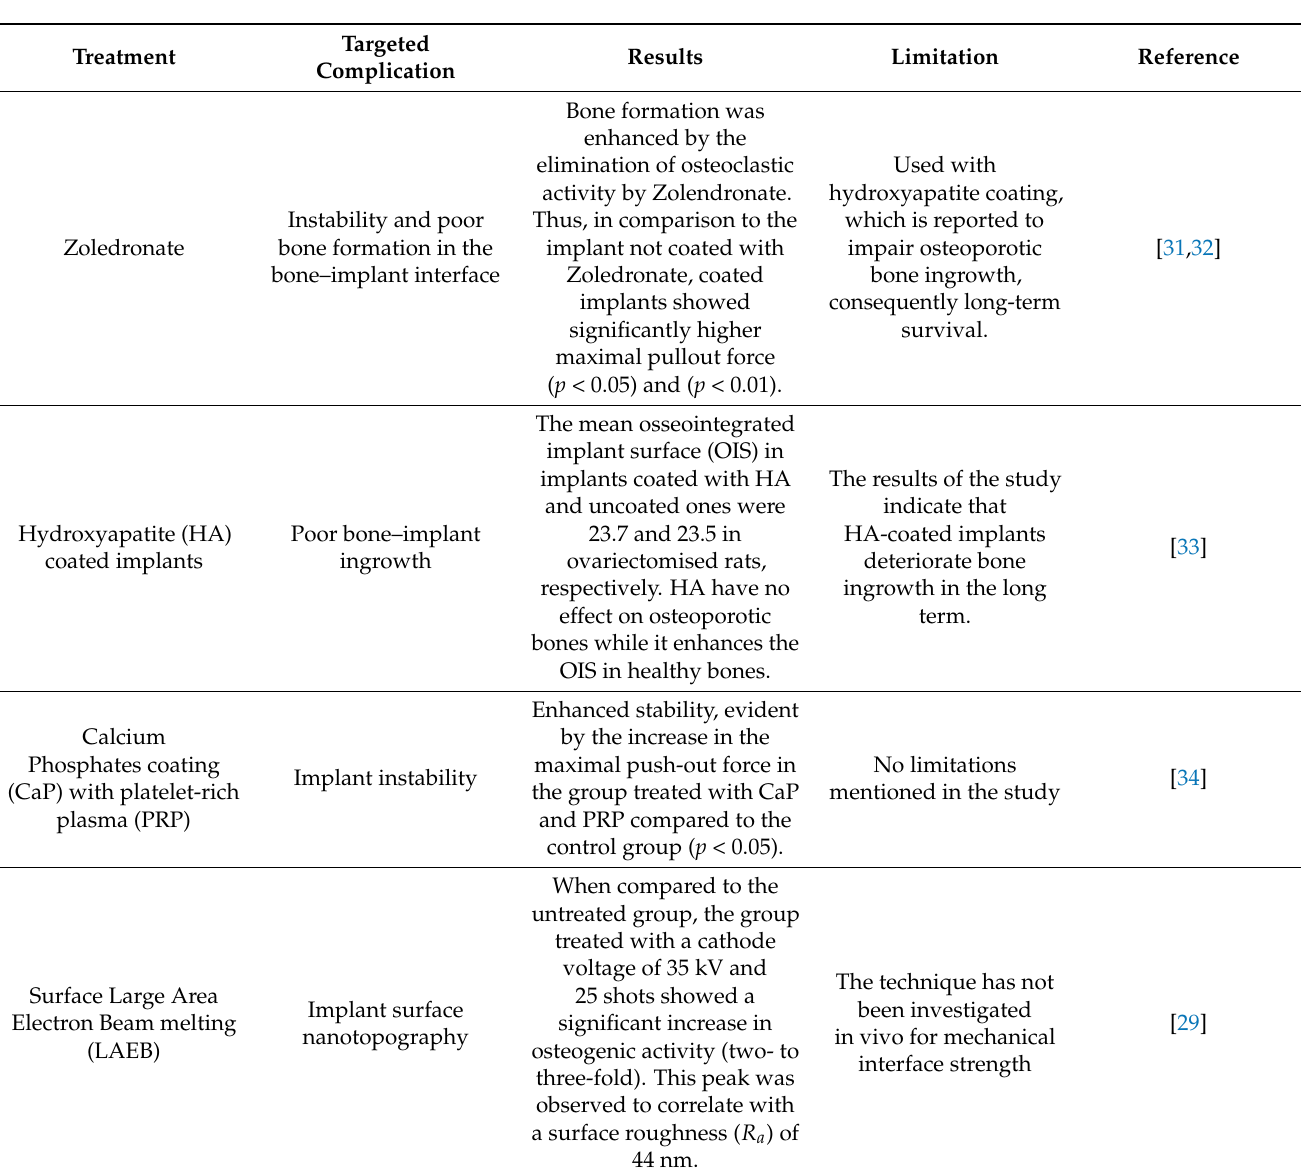
Table 5. Implant